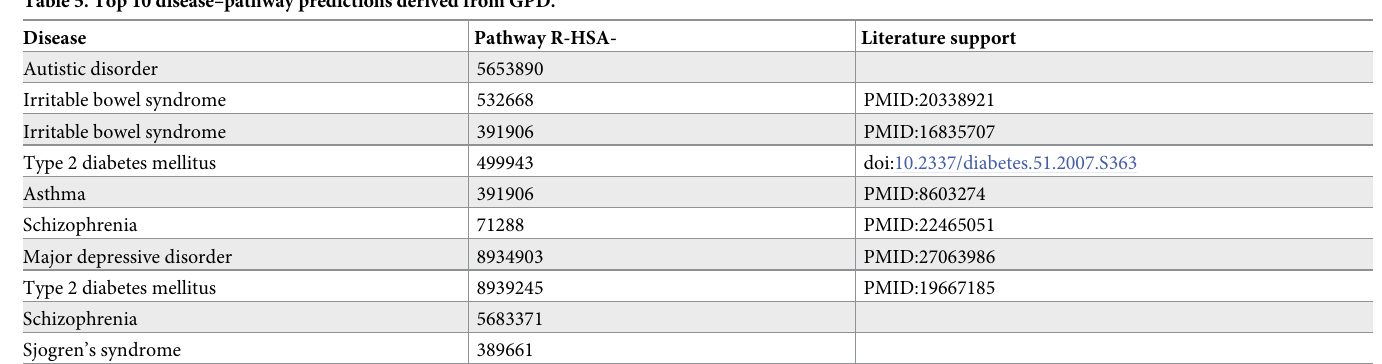
Table 5. Top 10 disease–pathway predictions derived from GPD. Disease